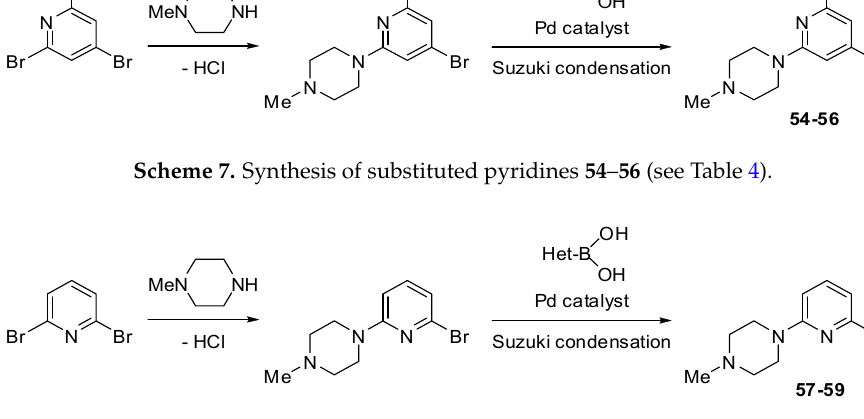
Table 1. 5-HT 7 binding affinities of pyrimidine derivatives 1 – 41 .